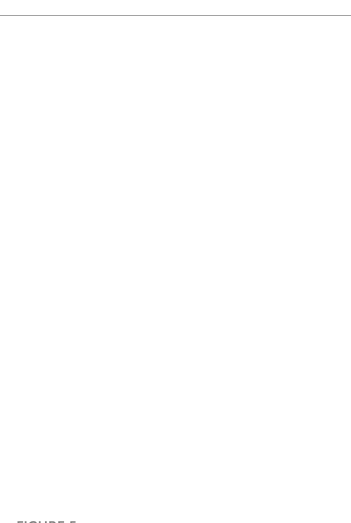
FIGURE 5 Spectral characteristics of healthy and infected